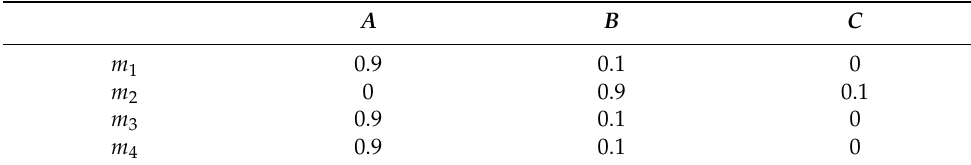
Table 5. The BPA of multi-sensor